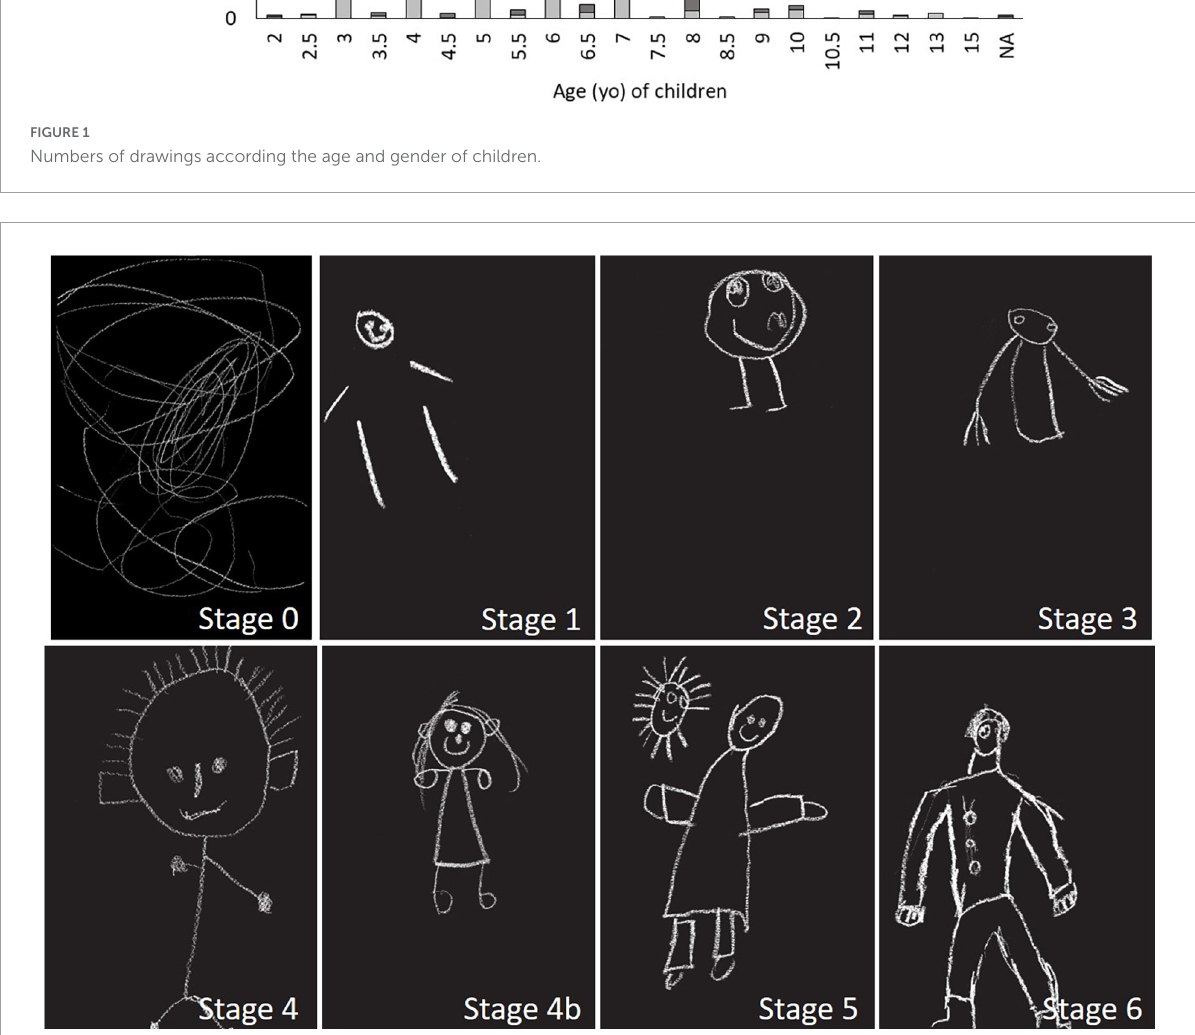
FIGURE2 Examples of the different types of human figures examined in our study.